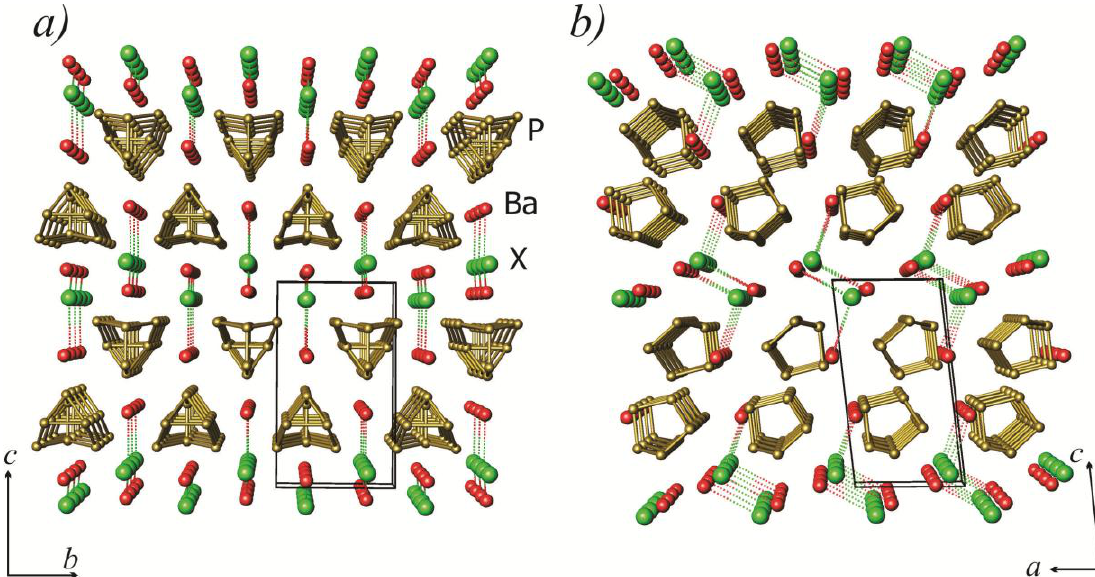
Figure 1. Crystal structure of Ba ( b ) [010] directions. Ba: red; P: brown; X: green. The shortest Ba–X distance is indicated with a dashed